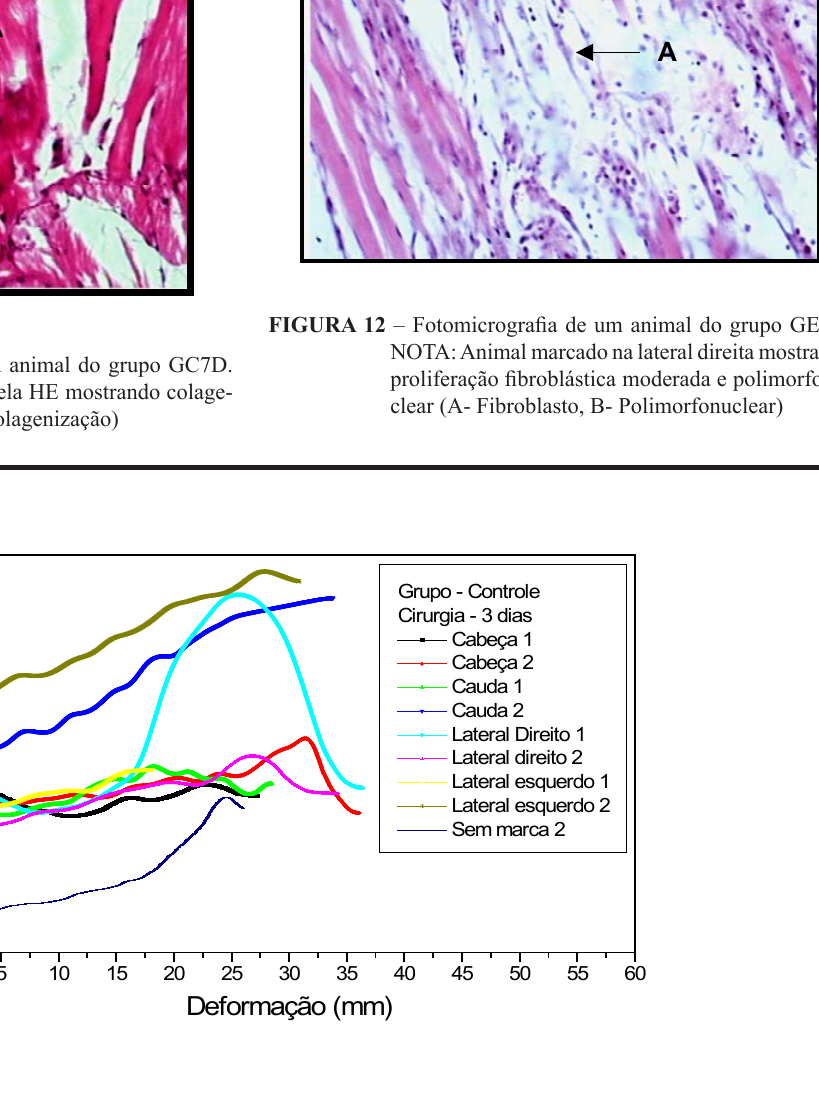
FIGURA 13 – Curva de carga versus deformação no grupo controle de três